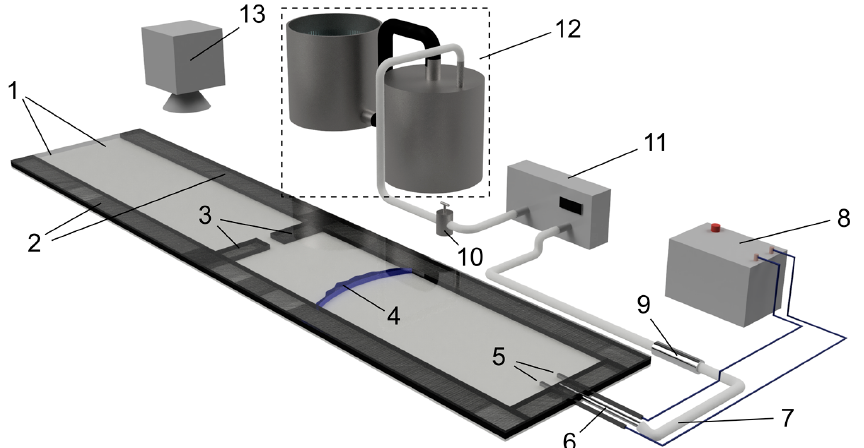
Figure 1. Sketch of the experimental facility: top and bottom acrylic plates (1), side walls of the channel (2), obstacle (3), flame front (4), spark electrodes (5), inlet nozzle (6), mixture supply hose (7), ignition coil (8), flame extinguisher (9), valve (10), gas volume meter (11), two-tank displacement gas meter (12), high-speed video or photo camera (13).